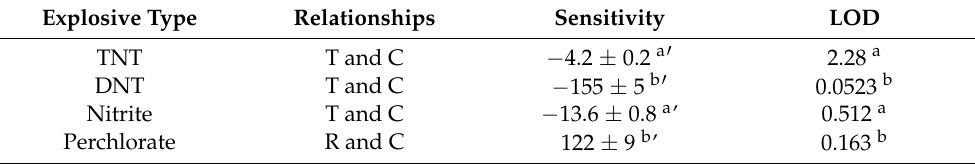
Table 3. Analytical performances of the proposed method from the colorimetric test of the explo- sives studied.